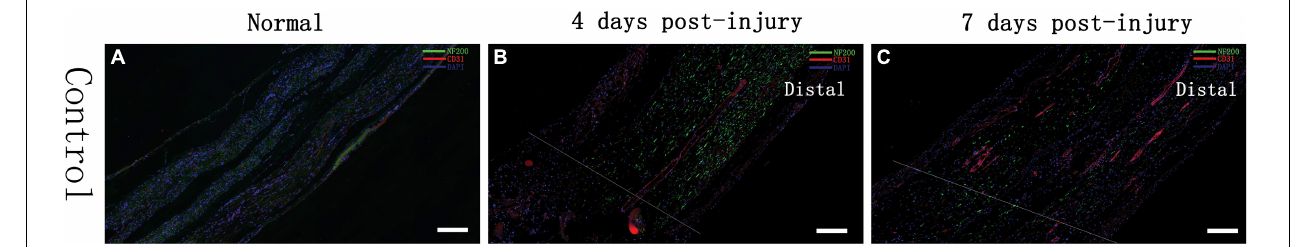
FIGURE 2 | Immunofluorescence assessment of the sciatic nerve in SD rats Changes in the expression of an axon-associated protein (NF-200) and a vascular endothelial cell protein (CD31) in the early stage of a contusion injury (4 days, 7 days) compared with controls. The scale bar represents 200 µ m. (A) Normal rat sciatic nerve; (B) 4 days after injury, rat sciatic nerve injury and beyond; (C) 7 days after injury, rat sciatic nerve injury and beyond.